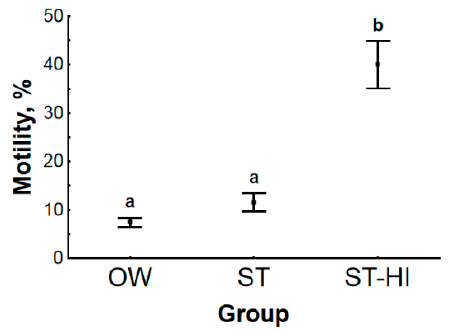
Figure 2. Motility percentage after testicular sperm in vitro maturation in experimental groups of sterlet. OW—fish were held in fish-farming ponds (water temperature 2 °C); ST—fish were adapted to spawning temperature of 14 °C, spermiation was not induced; ST-HI—fish were adapted to spawning temperature of 14 °C, spermiation was induced. Dots represent the means, and whiskers represent the standard errors. Values with different letters are significantly different ( p < 0.05, multiple comparisons of mean ranks for all groups).